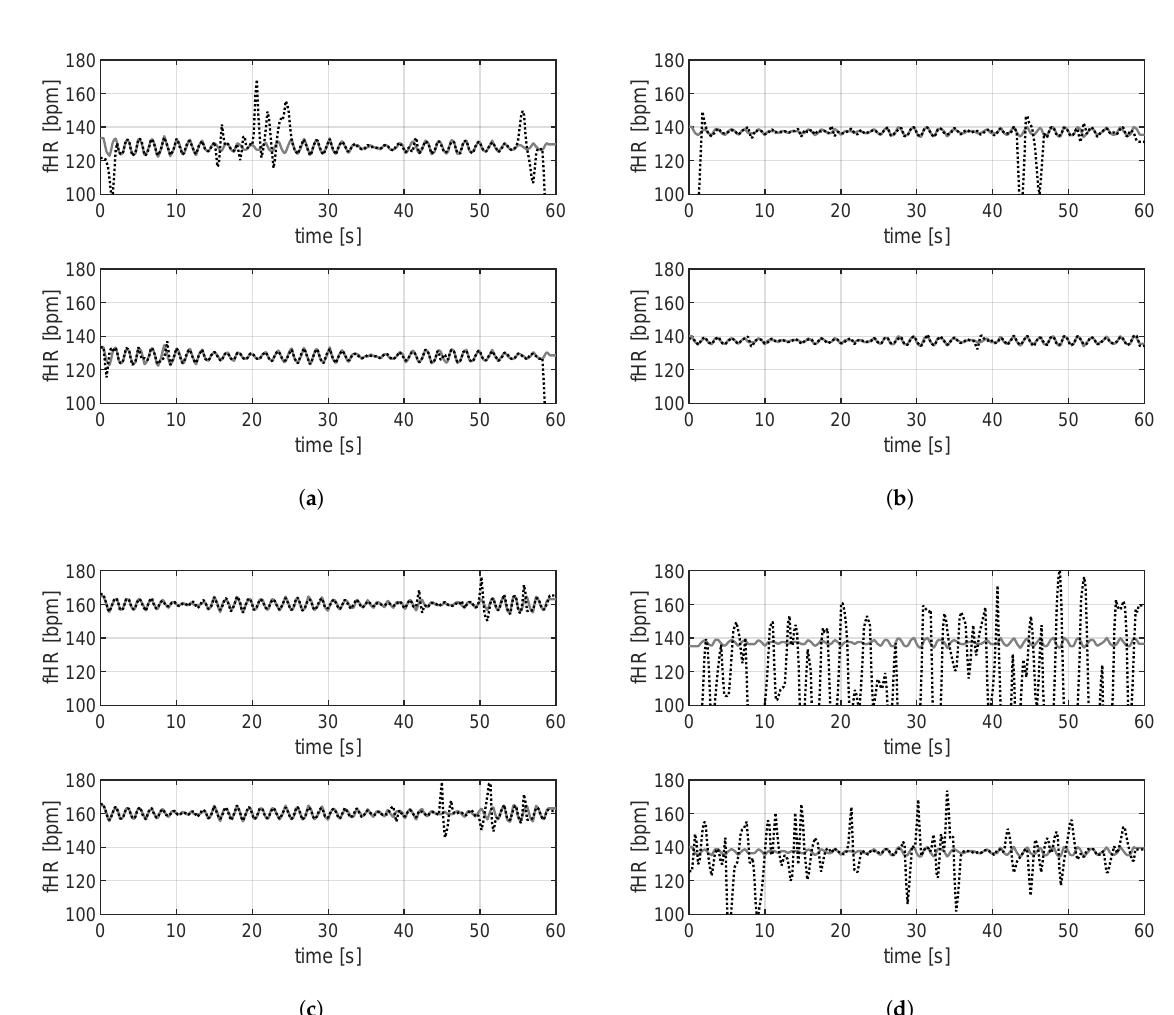
Figure 11. Examples of outcomes on DS-SS. Comparison of the fHR estimation with VA ( upper ) and the proposed method, ( lower ) the reference is the gray line.